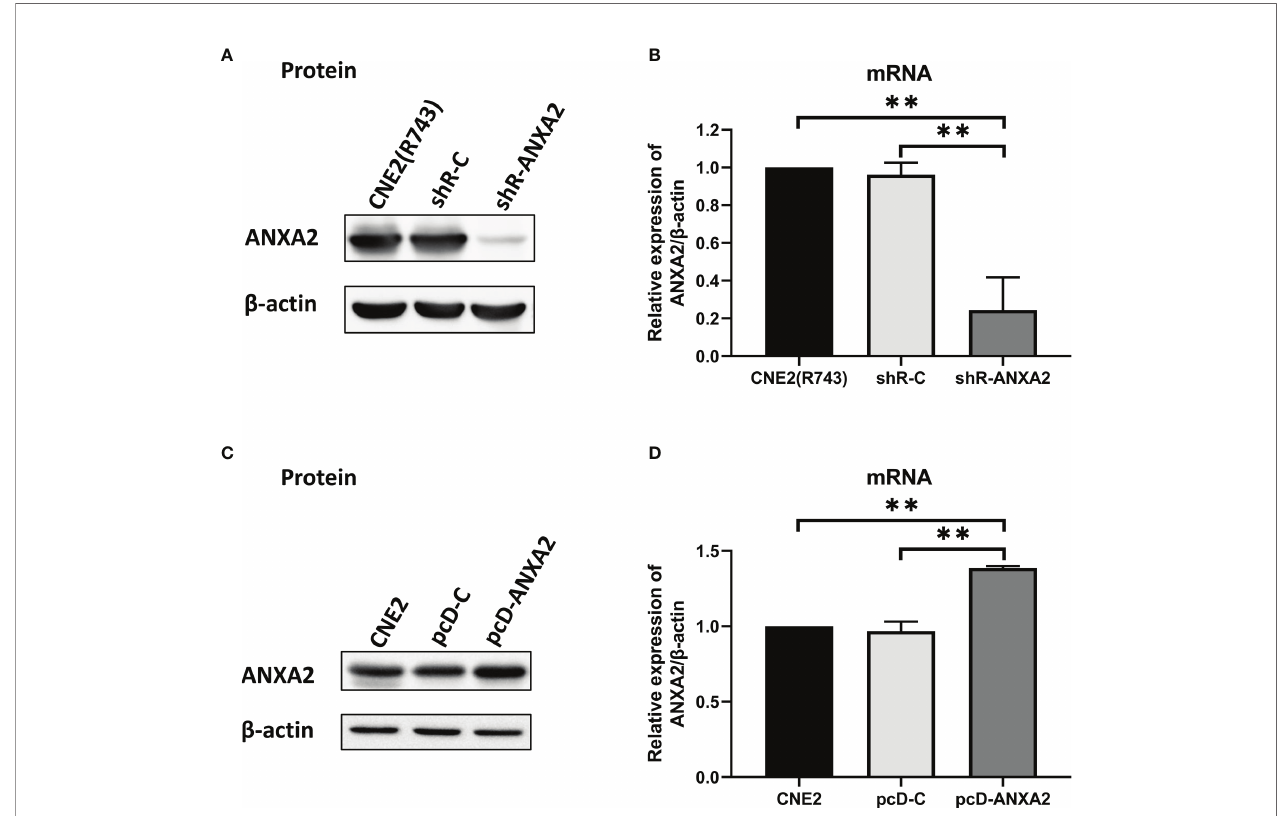
FIGURE 2 | Generation of ANXA2 knockdown and overexpression in NPC cells. (A) Western blotting determines the ANXA2 expression in shR-ANXA2, shR-C and CNE2(R743) cells, and b -actin serves as a loading control; (B) qPCR assay quanti fi es the relative ANXA2 expression in shR-ANXA2, shR-C and CNE2(R743) cells; (C) Western blotting determines the ANXA2 expression in pcD-ANXA2, pcD-C and CNE2 cells, and b -actin serves as a loading control; (D) qPCR assay quanti fi es the relative ANXA2 expression in pcD-ANXA2, pcD-C and CNE2 cells. All values are presented as mean ± SD, n = 3. ** P <